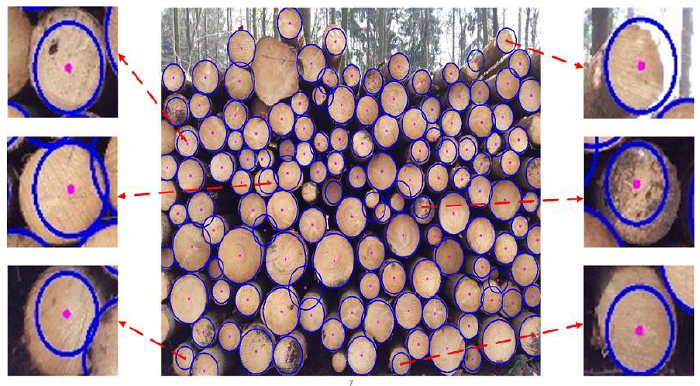
Figure 9. Results of Hough transform and some